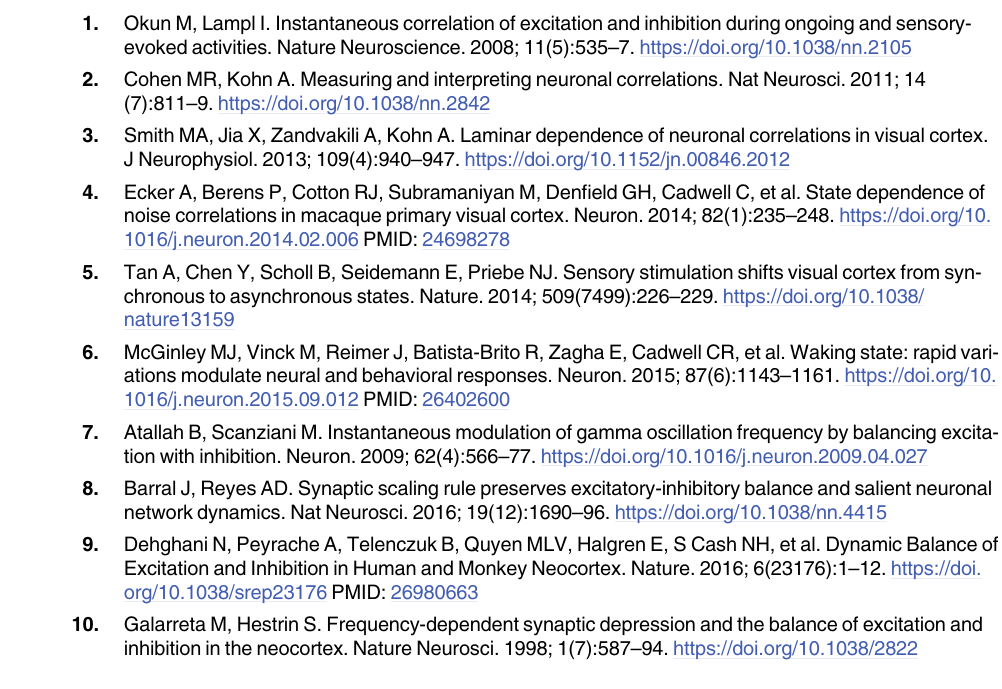
parameter β . d : Same as c , but for the case when weights are above β . e : Same as a , but for Oja’s rule when weights are below parameter β . f : Same as e , but for the case when weights are above β